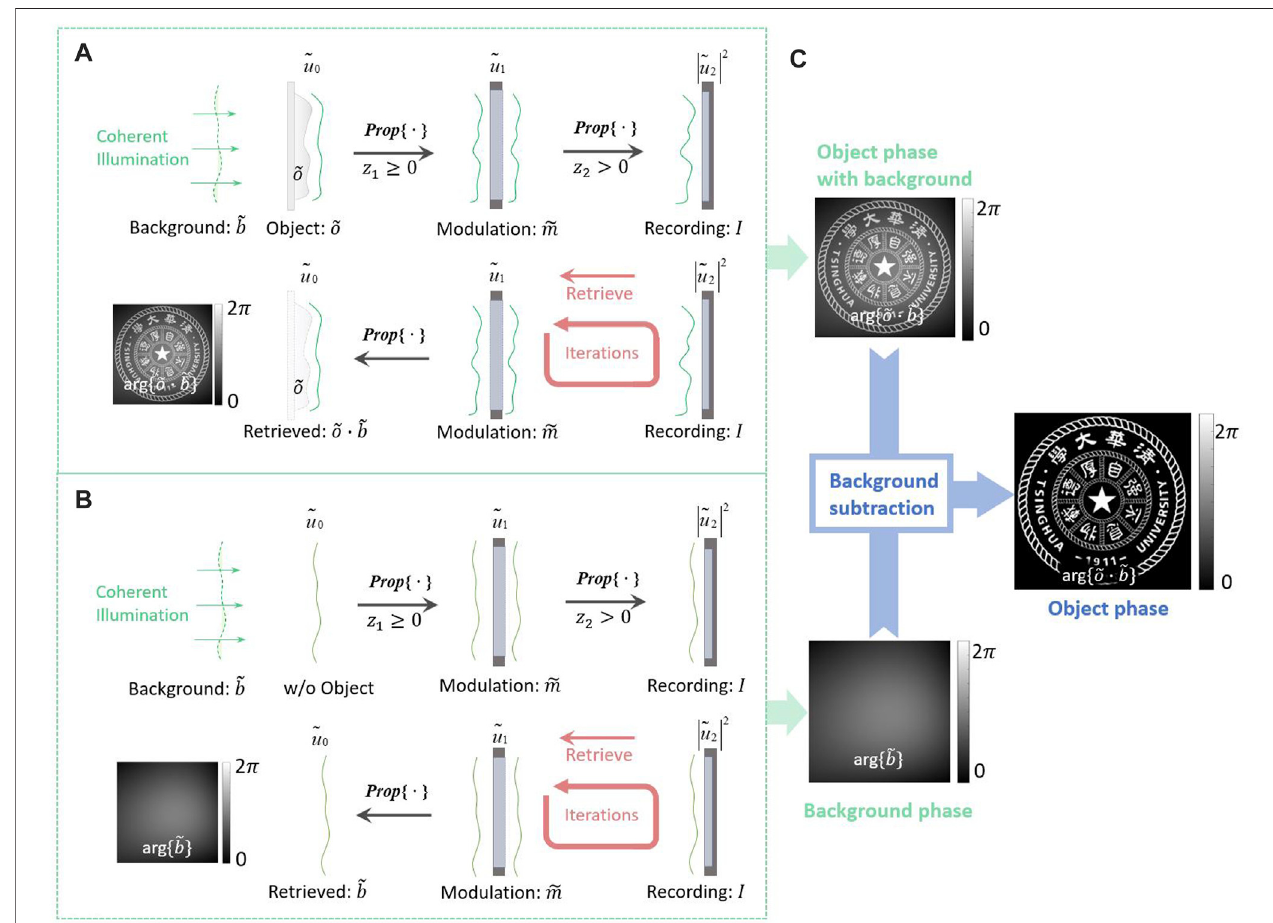
FIGURE1| Schematicofthediffractionimagingtechniquewhenrecordingandretrieving. (A) Measuringandreconstructingtheobjectphasewiththebackground phase. (B) Measuring and reconstructing the background phase. ~ m : modulation or support constraint. (C) Acquiring the object phase with background subtraction.